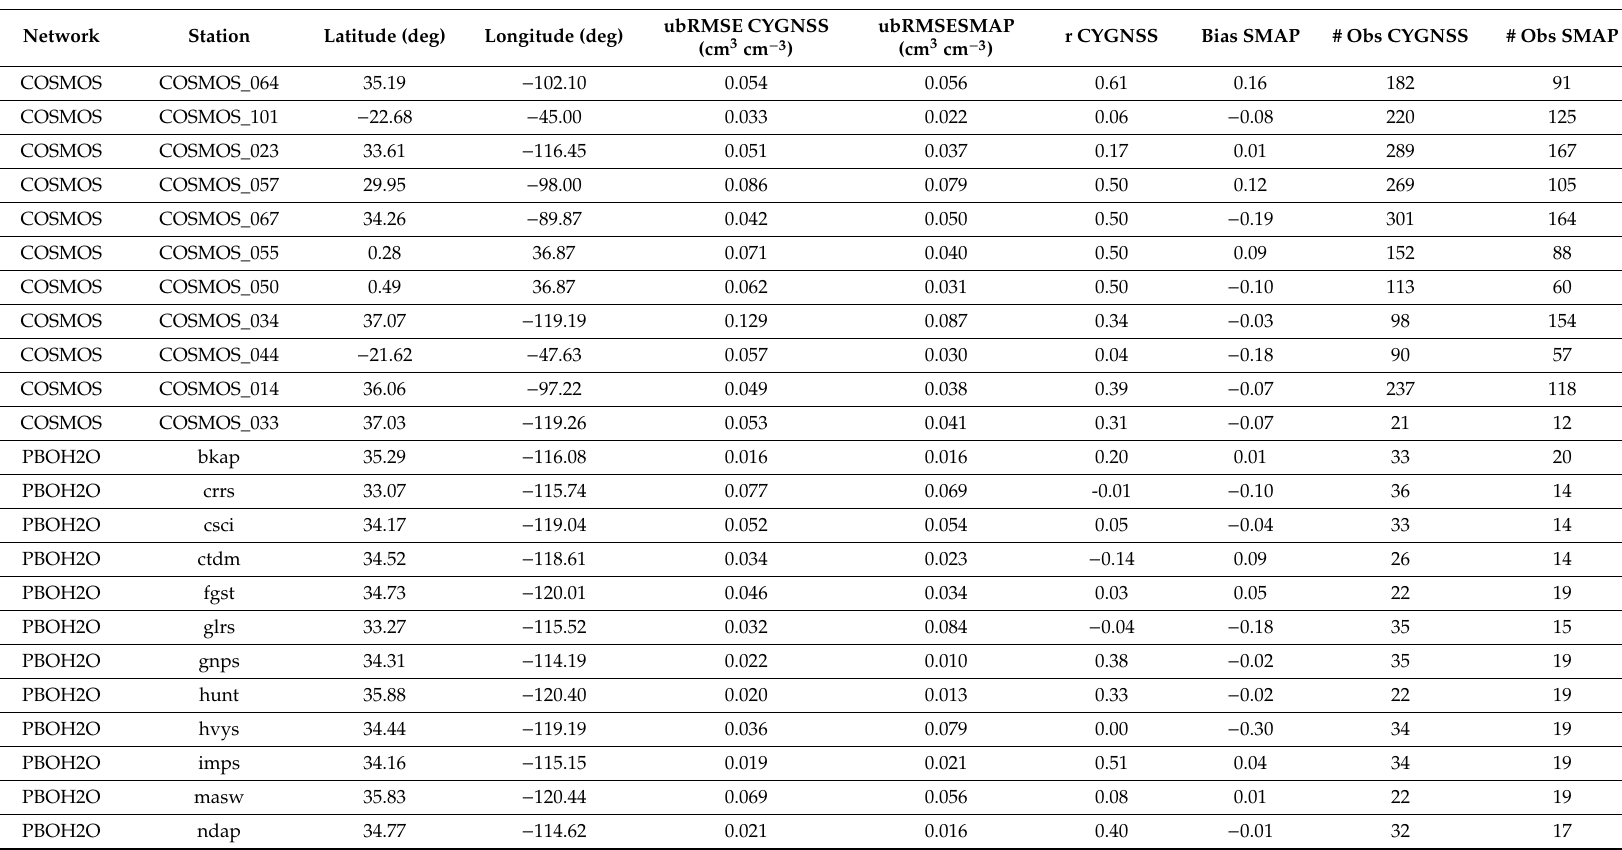
Table A1. Location information and statistics for each in-situ soil moisture station used for validation. Unbiased root-mean-square errors (ubRMSEs) for CYGNSS are shown as well as those for SMAP, which are shown for context. The correlation coe ffi cient (r) between CYGNSS soil moisture retrievals and in-situ observations is shown. The bias between SMAP retrievals and in-situ observations is the same as for CYGNSS retrievals and in-situ observations, since CYGNSS retrievals are already bias-corrected with respect to SMAP. The number of CYGNSS and SMAP observations used for calculation of ubRMSEs, r, and the bias are also